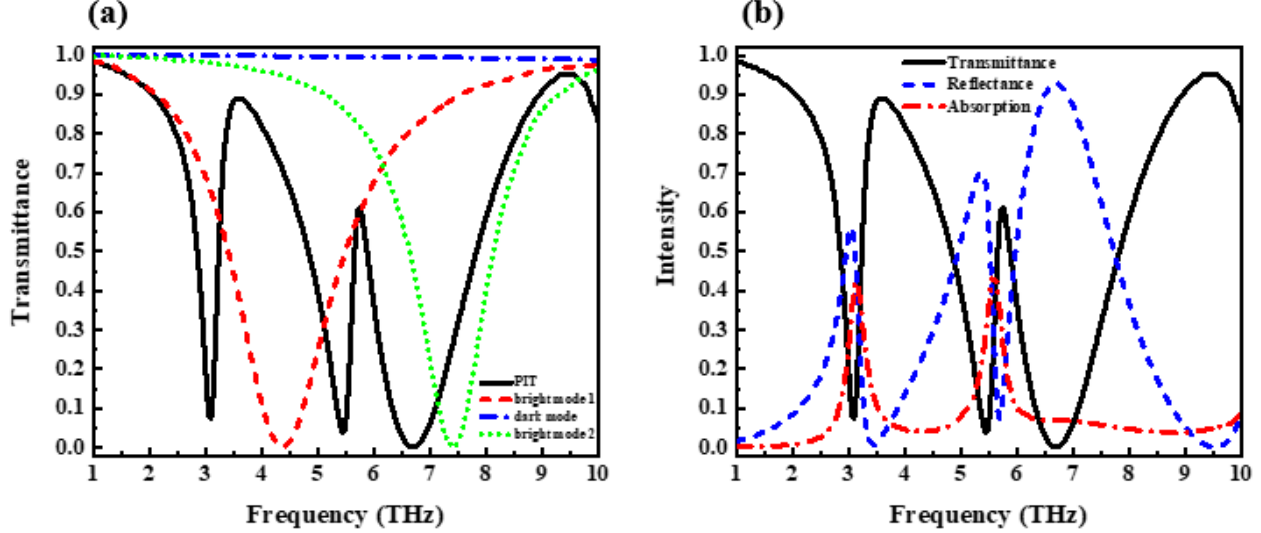
Figure 2. ( a ) Transmission spectrum in different modes. ( b ) Transmission characteristics of this design.